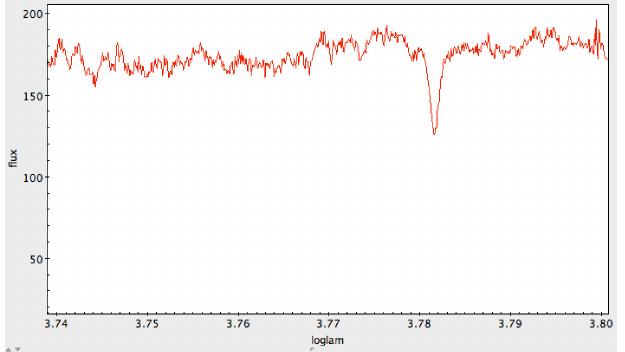
Fig. 77.— A quick look at an SDSS spectrum, using Plane Plot